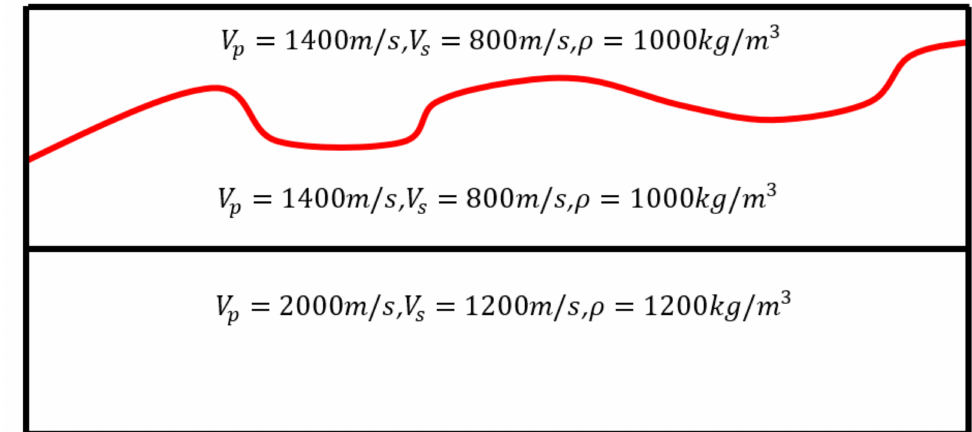
Figure 1. The new model with the horizontal surface for calculating wavefield with complex topog- raphy. The red line is the surface